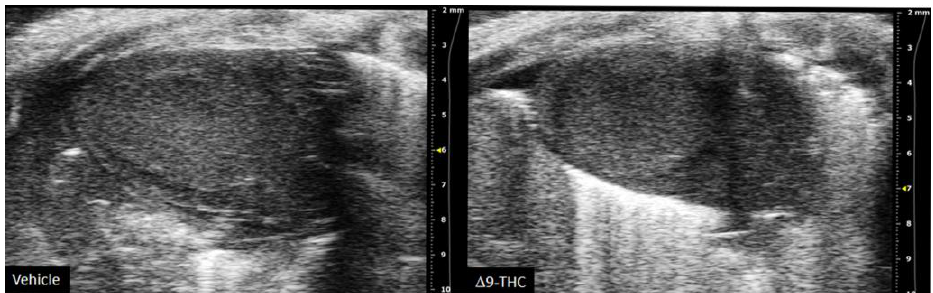
Figure 2. Maternal exposure to 3 mg/kg i.p. daily from gestational day 6–22 results in decreased heart size and stroke volume at postnatal day 1. Representative echocardiography (long-axial view of the left ventricle) from vehicle and THC rat offspring at postnatal day 1.